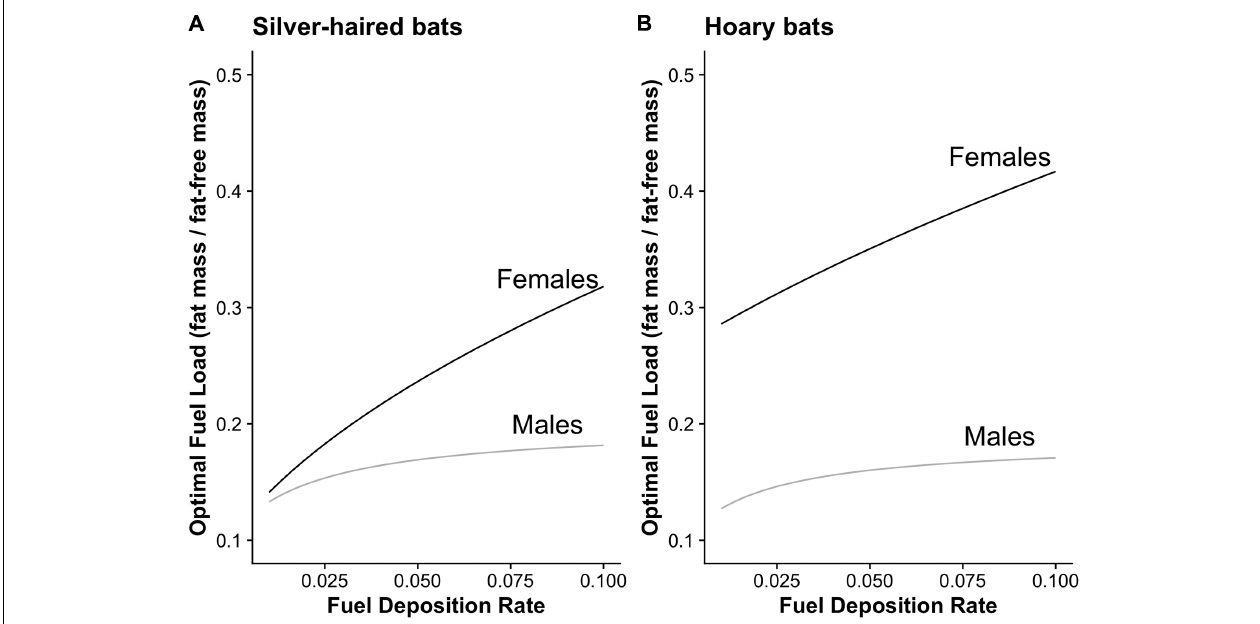
FIGURE 1 | Qualitative predictions of optimal fuel load across a range of fuel deposition rates for silver-haired bats and hoary bats using time and energy minimizing strategies as well as heterothermic and homeothermic thermoregulatory strategies. (A) The optimal fuel load for female heterothermic time minimizing silver-haired bats (black line) is predicted to be greater than for male heterothermic energy minimizing silver-haired bats (gray line). (B) Similarly, female homeothermic time minimizing hoary bats (black line) are predicted to have greater optimal fuel load than male heterothermic energy minimizing hoary bats (gray line), with the further prediction that the observed difference would be greater than the difference for silver-haired